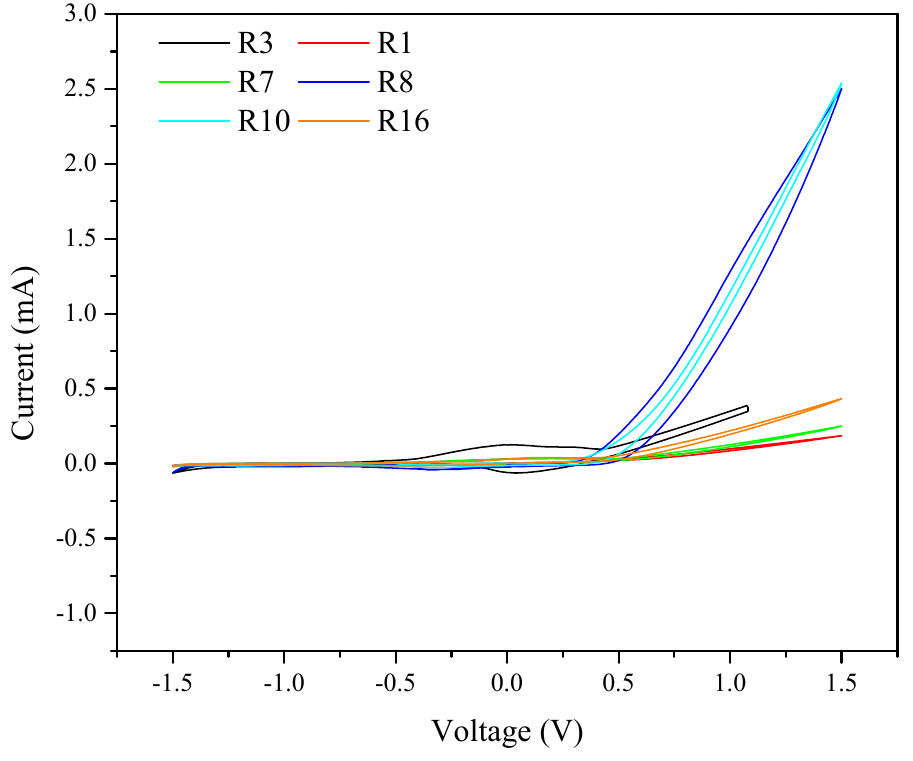
Figure 3. Cyclic voltammetry graphs for selected runs.